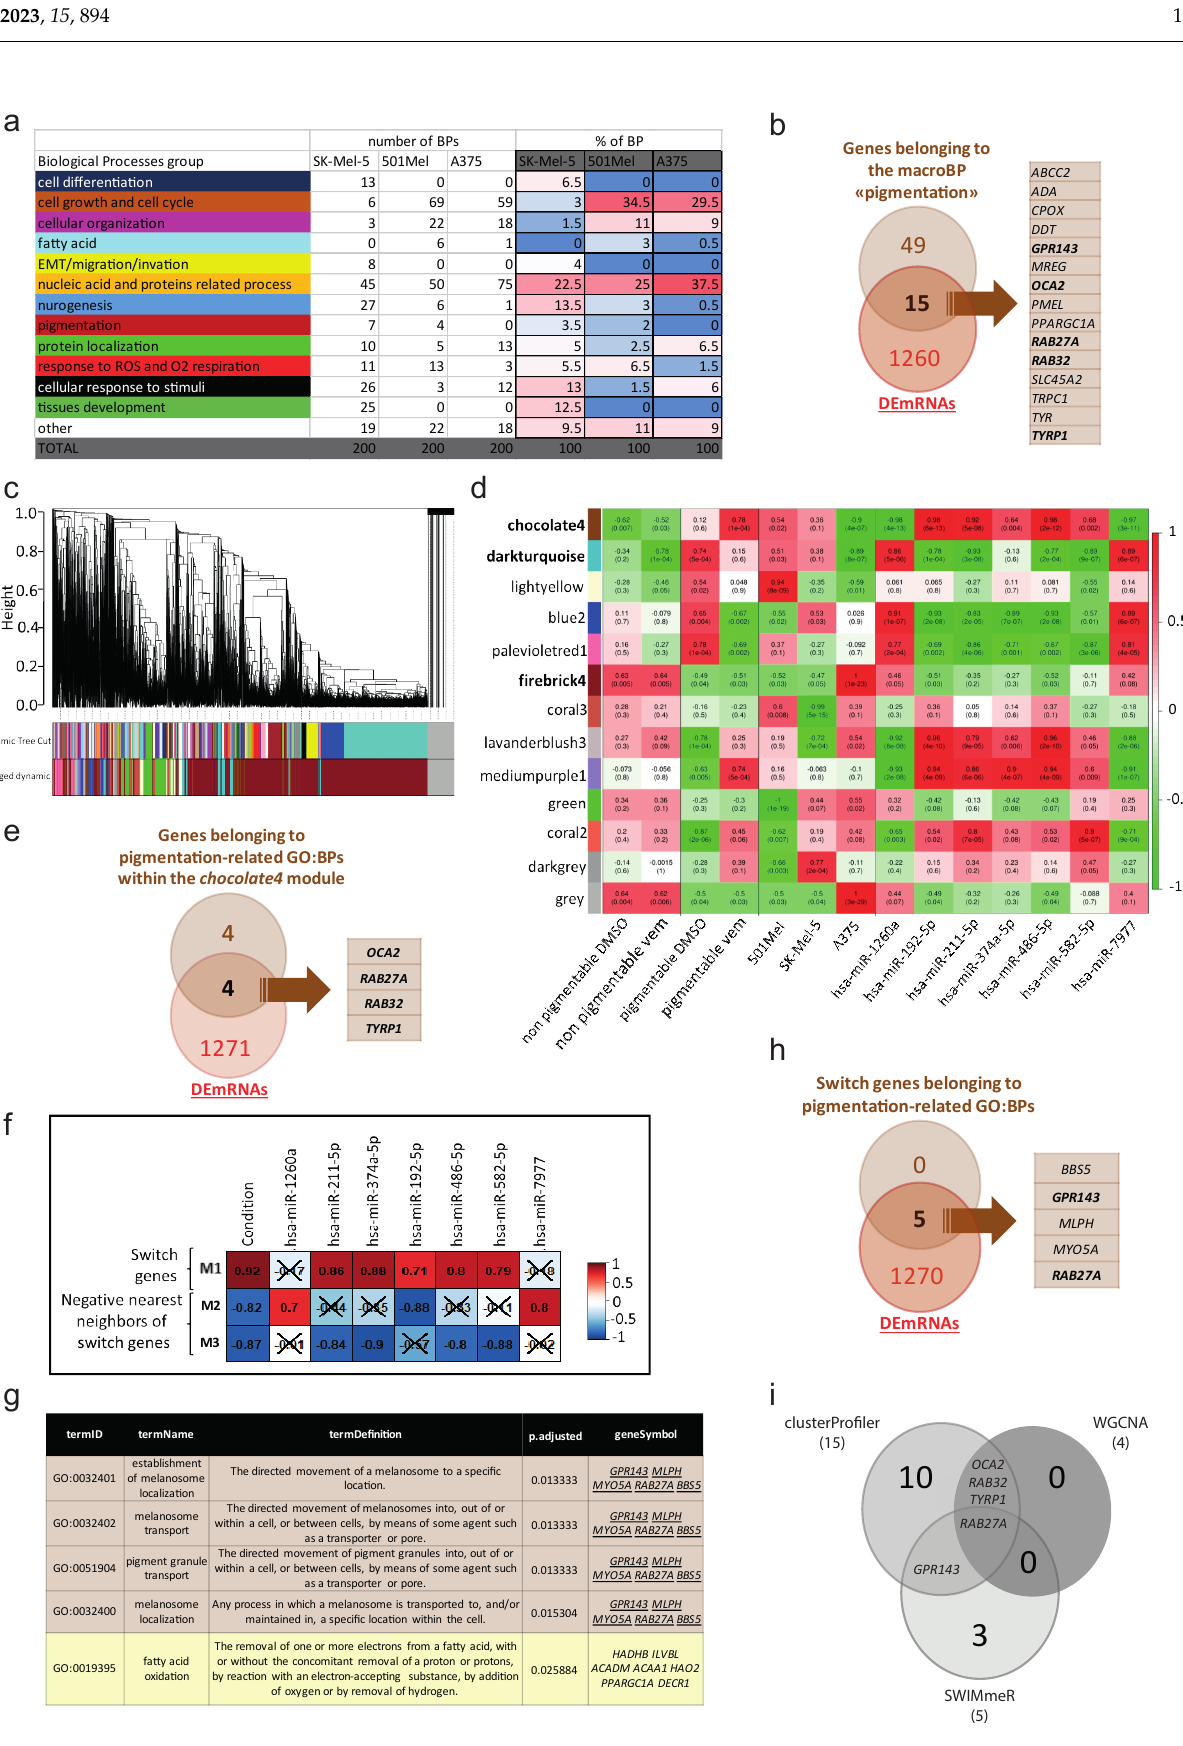
Figure 2. Selective enrichment of the biological process “pigmentation” in pigmentable vs. non- pigmentable cell lines upon vem treatment. ( a , b ) clusterProfiler analysis of vem-treated